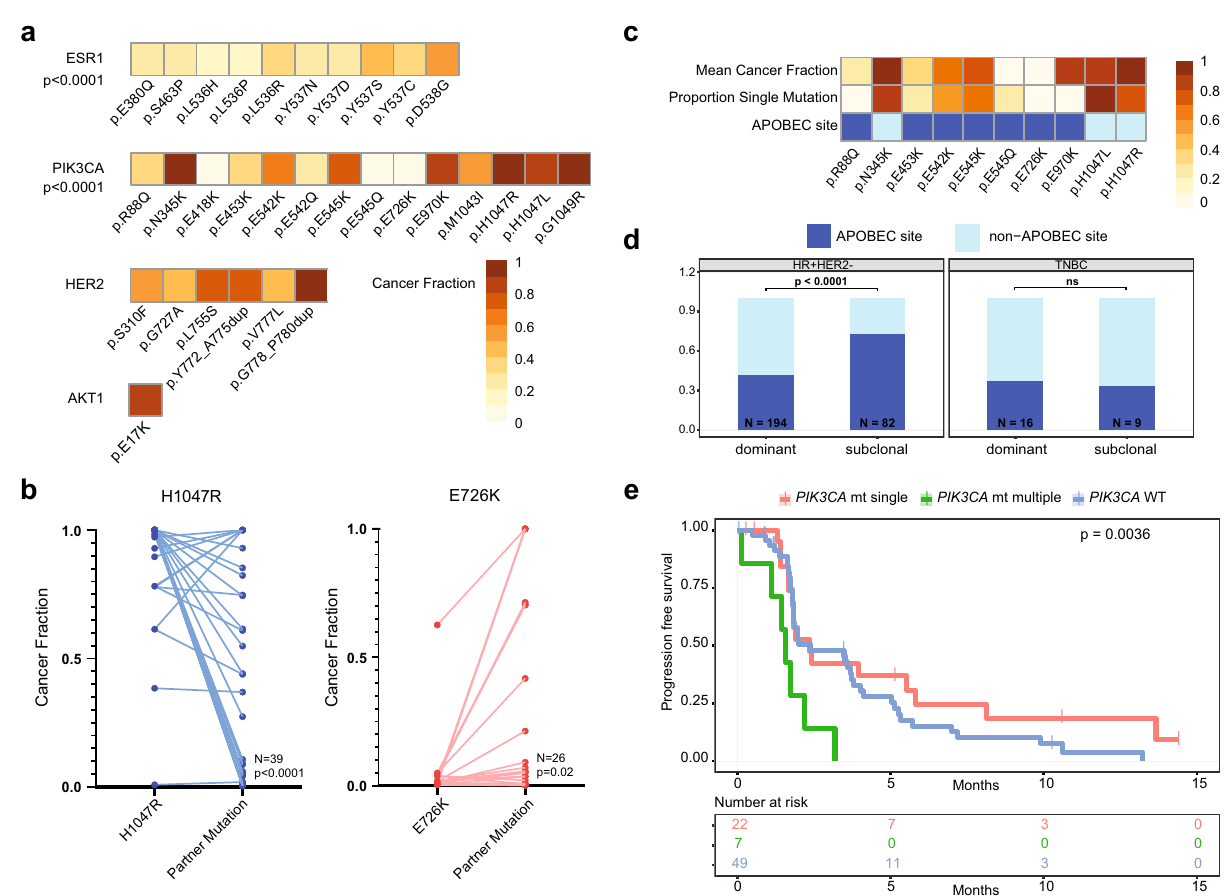
Fig. 6 Subclonal multiple PIK3CA mutations and resistance to fulvestrant. a Cancer fractions of individual pathogenic hotspot mutations in indicated gene, including hotspots with at least 3 mutations in the overall data set or for any indel. p -value from two-sided Kruskal – Wallis test for variation in cancer fraction across mutations in gene ( ESR1 p < 0.0001, PIK3CA p < 0.0001). b Analysis of patients with H1047R ( left , N = 39) and E726K ( right , N = 26) dual pathogenic PIK3CA mutations, with linkage of cancer fraction of indicated PIK3CA mutation with the other PIK3CA mutation present in the same patient. The p -values indicated are derived from two-sided Mann – Whitney U -tests (H1047R p < 0.0001, E726K p = 0.02). c Analysis of individual recurrent hotspot mutations in HR + HER2- PIK3CA mutant disease ( N = 202) with mean cancer fraction, proportion of mutations detected as a single PIK3CA mutation, and indication of whether the mutation occurs at an APOBEC consensus site. Mutations occurring at least 3 times in the HR + HER2- disease dataset included. Cancer fraction and proportion single mutations is lower at APOBEC sites, P < 0.001, two-sided Fisher ’ s exact test both comparisons. d Proportion of PIK3CA mutations that occur at APOBEC consensus sites, by cancer subtype (HR + HER2- N = 197, TNBC N = 21), and clonally dominant ( N = 194 mutations within HR + HER2- breast cancers and N = 16 within TNBC breast cancers) versus subclonal PIK3CA mutation ( N = 82 mutations within HR + HER2- breast cancers and N = 9 within TNBC breast cancers). P -value from two-sided Fisher ’ s exact test. ns, not signi fi cant. e Progression free survival (PFS) in patients on fulvestrant in treatment cohort A in plasmaMATCH divided by PIK3CA mutation status. Cohort A patients with available sequencing data included (78/84). PIK3CA WT, median 2.4 months, HR -. PIK3CA single mt, median 2.4 months, HR 0.71, 95% CI 0.41 to 1.22. PIK3CA multiple mt, median 1.6 months, HR 3.15, 95% CI 0.88 to 11.33. p -value from log-rank test. HR > 1 indicates worse PFS for that group. WT, wild-type; mt,